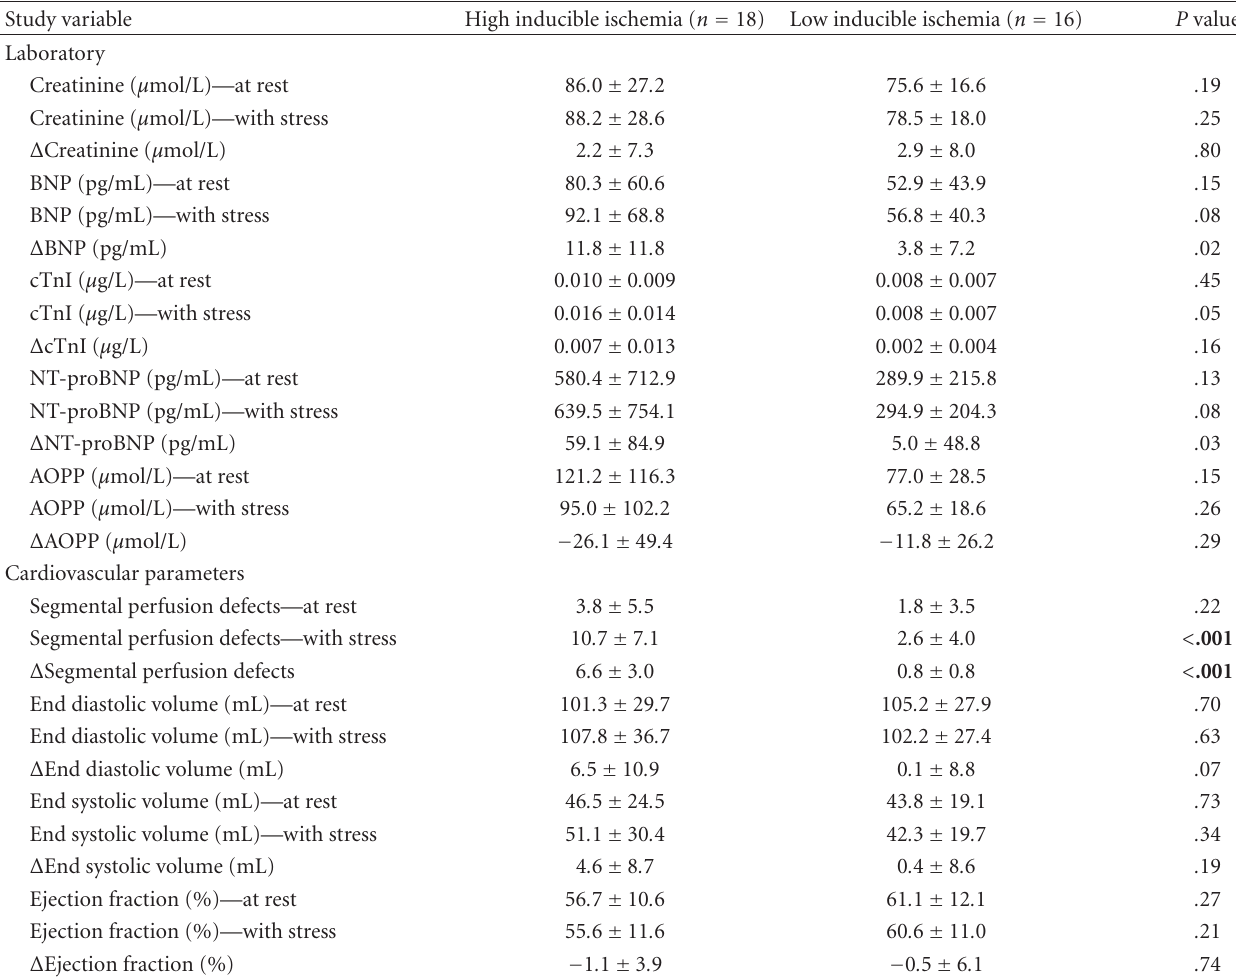
Table 2: Changes in cardiac biomarkers, oxidative stress, and various cardiovascular imaging parameters compared between the high and low ischemia (number of inducible myocardial perfusion defects)